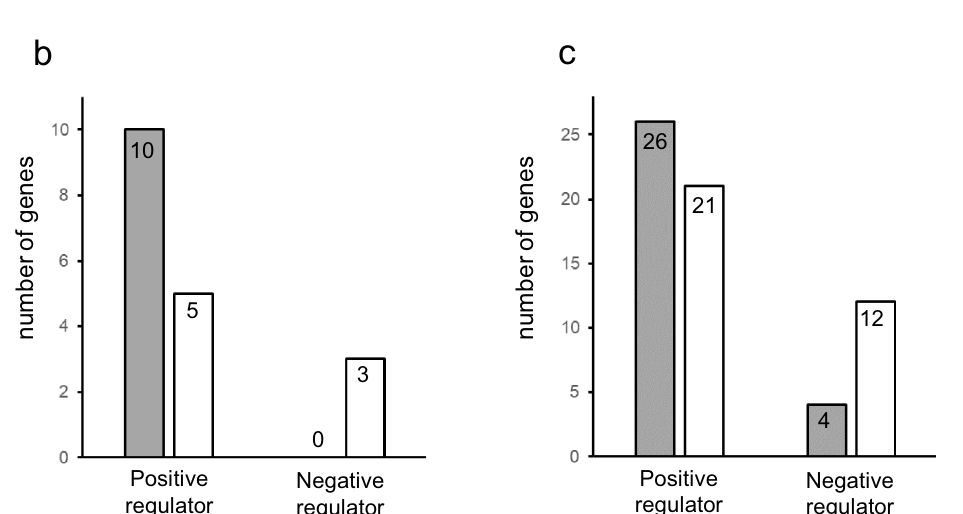
Figure 3. Summary of large-scale analysis of overexpression effects of extracted genes. ( a ) Effects of overexpressions on insulin secretion at 20 mM glucose are summarized. Insulin secretion from dox-treated overexpressing cells relative to that from dox-untreated cells at 20 mM glucose (defined as 100, dashed line) are presented. Insulin secretion analyses were performed 3 or 5 times for each gene. Black and white columns represent genes which had been found in the previous microarray analysis to be preferentially expressed in the H and ML groups, respectively. Data are means ± SEM. Mean values were tested for significance using a one-sample t test. * P < 0.05, ** P < 0.01. ( b , c ) Grey bars represent numbers of genes preferentially expressed in MIN6 cells with high glucose-responsiveness and white bars those with mildly low glucose-responsiveness, as identified by the functional screening ( b ) and by literature search ( c